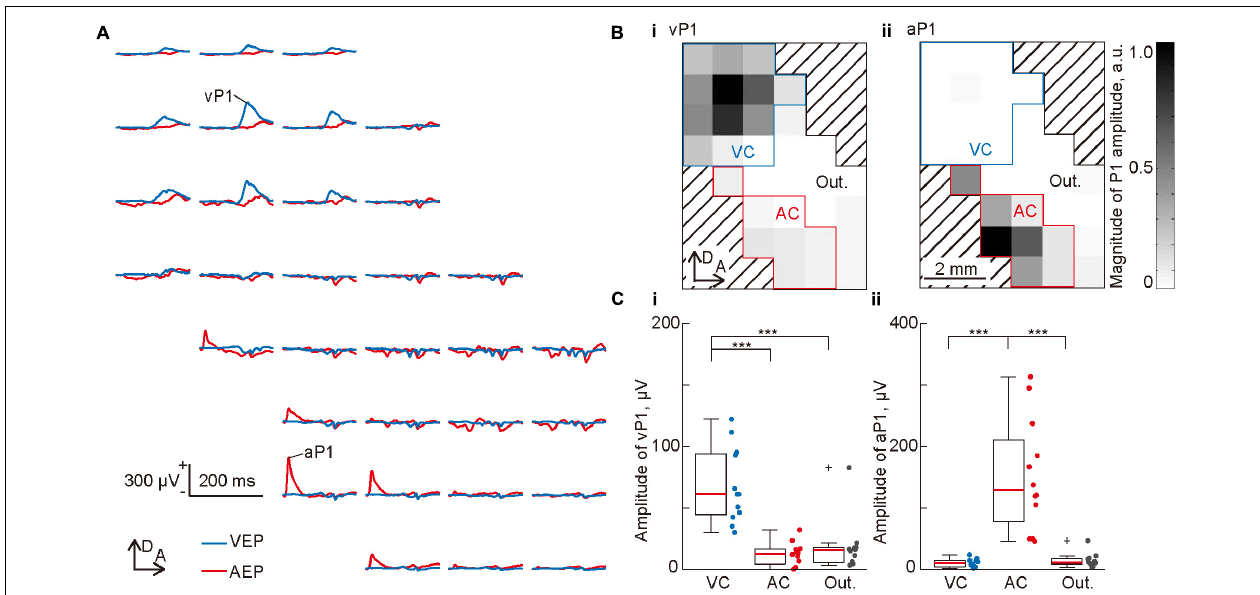
FIGURE 2 | Mapping of the evoked potentials in the visual and auditory cortices. (A) Representative mapping of the waveform of a flash-elicited visual evoked potential (VEP; blue lines) and click-elicited auditory evoked potential (AEP; red lines) recorded simultaneously from 32 recording sites. Each waveform is approximately aligned in the spatial coordinates of the recording sites of the surface microelectrode array. Amplitudes of the visual P1 (vP1) and auditory P1 (aP1) was quantified as the maximum amplitude within 200 ms from the onset of the stimulus. (B) Spatial distributions of (i) vP1 and (ii) aP1. The gray level at each grid corresponds to the P1 amplitude at each recording site. The recording sites surrounded by blue or red lines were categorized as the putative visual cortex (VC) or auditory cortex (AC), which showed a vP1 or aP1 amplitude larger than 10% of the maximum amplitude. The other recording sites were categorized as the outer region. (C) Regional differences in (i) vP1 and (ii) aP1. Dots indicate the mean amplitudes of vP1 and aP1 among each putative region in individual animals ( n = 12 animals). Asterisks indicate statistical significance in the post hoc analysis: *** p < 0.001 (Wilcoxon one-sided signed-rank test with Bonferroni correction for three comparisons, following the Kruskal-Wallis